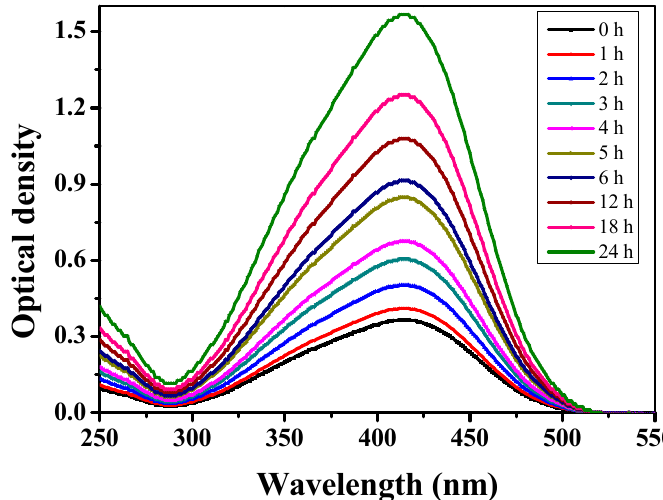
Figure 1. UV-Vis spectral analysis of control and freshly extracted C. arvensis AgNPs .